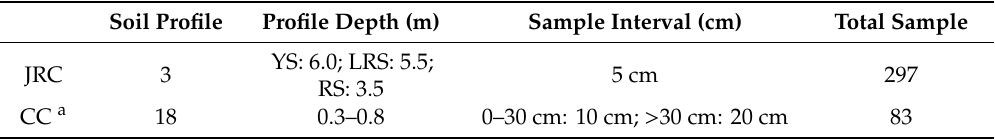
Table 2. Number of sampling profiles and total samples, profile depth, and sample